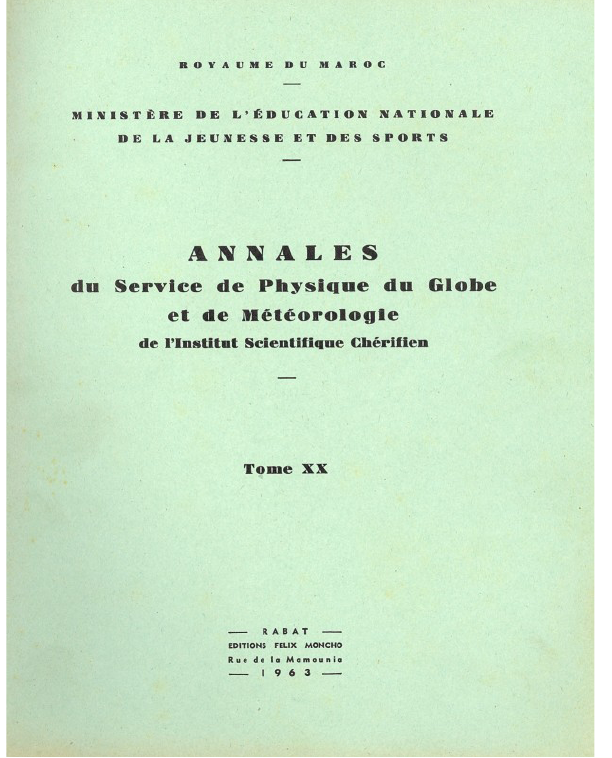
Figure 3. Cover of the “Annales du Service de Physique du Globe et de Météorologie”, published from 1938 to 1963 by the